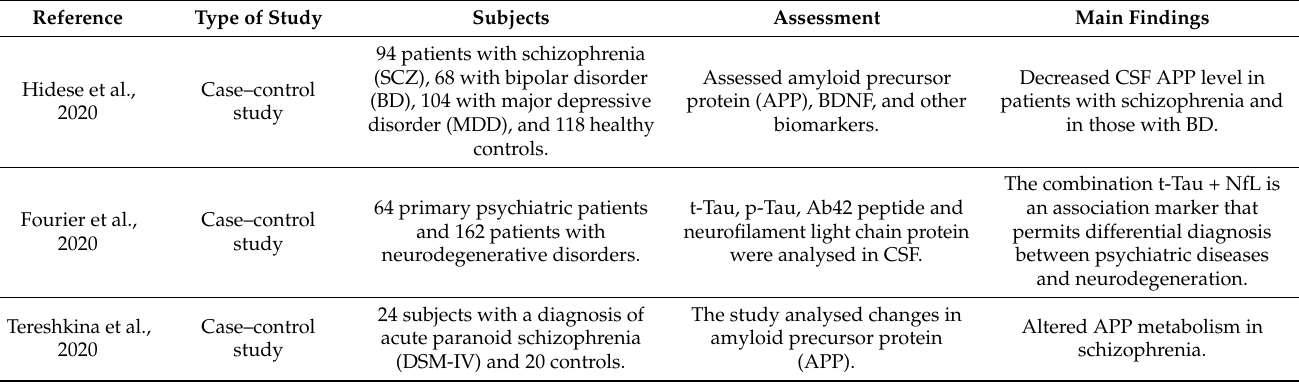
Figure 1. Flow diagram. Table 1. Summary of the selected articles.